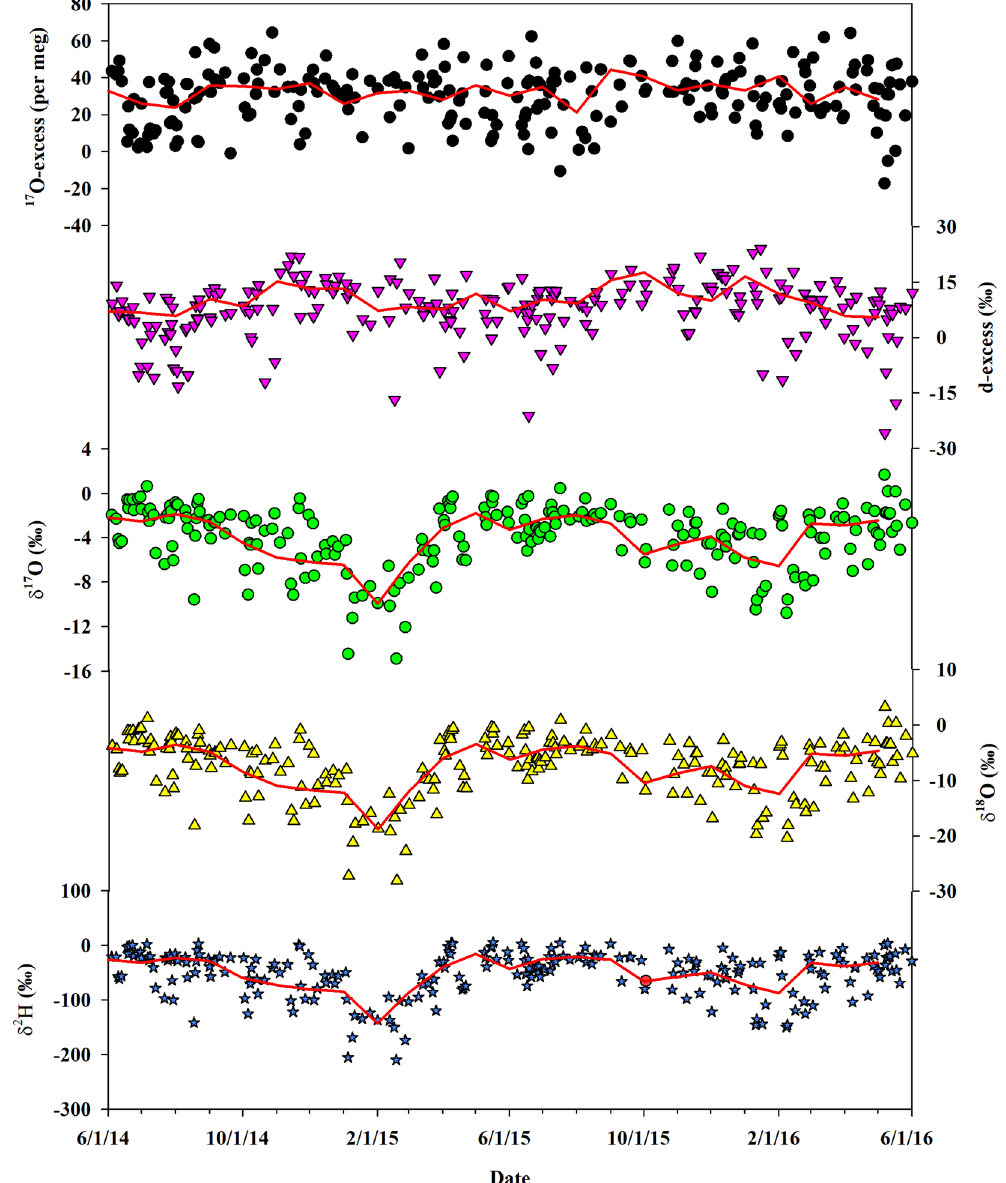
Figure 2. Water stable isotope variations on the event-based sampling (circles, triangles and stars) and corresponding monthly means (red lines) in precipitation between June 2014 and May 2016 in west-central United States. From top to bottom: 17 O-excess, d-excess, δ 17 O, δ 18 O and δ 2 H during the individual